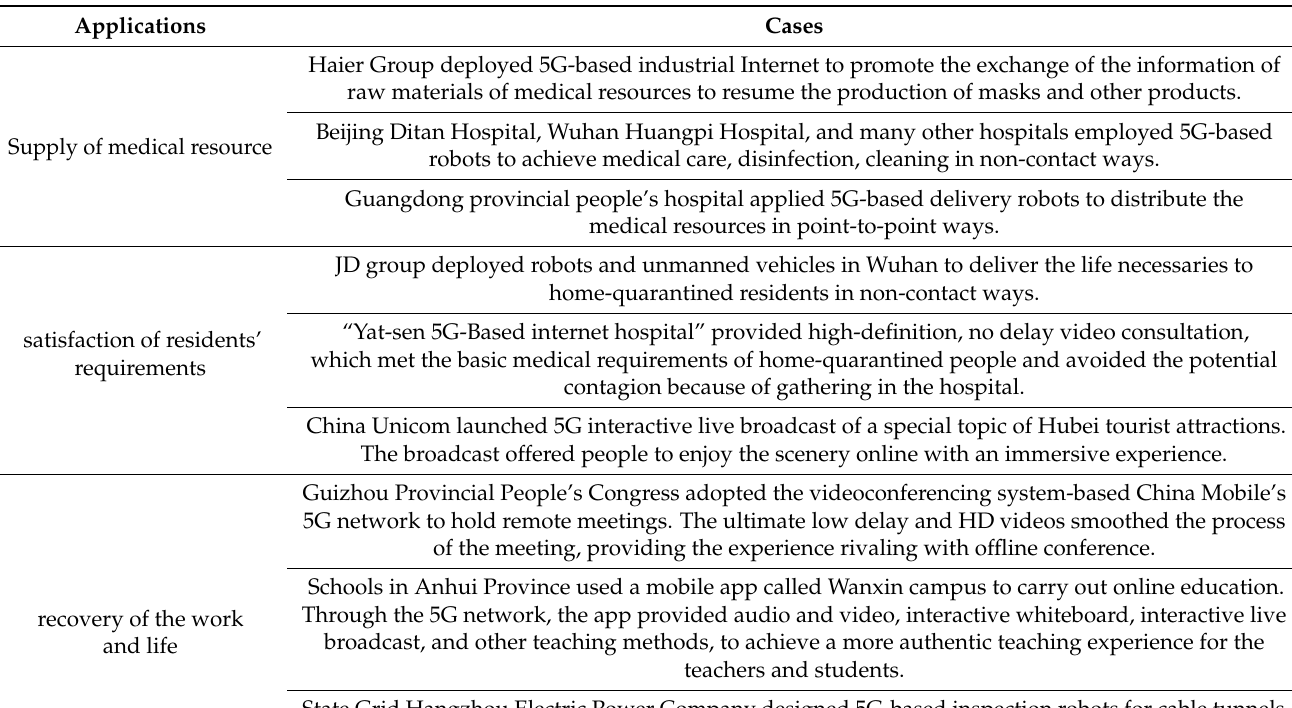
Table 5. The cases in which the 5G enabled logistics